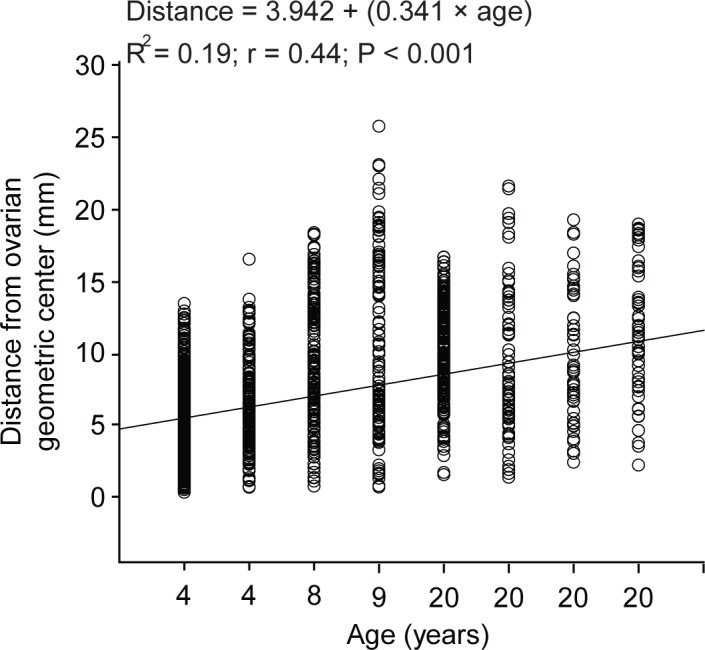
Age effect on the mean distance of equine preantral follicles to the ovarian geometric center recorded in histological sections (n = 240).Each circle of the graph represents an evaluated preantral follicle (n = 9,284). Linear regression and correlation analyses are presented.